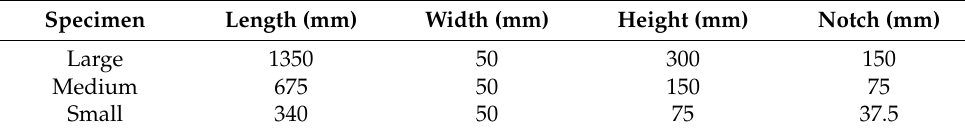
Figure 2. Left : scheme of a three-point bending test and specimen geometry; right : scheme of crack propagation from the notch tip during the test. Table 3. Specimens’